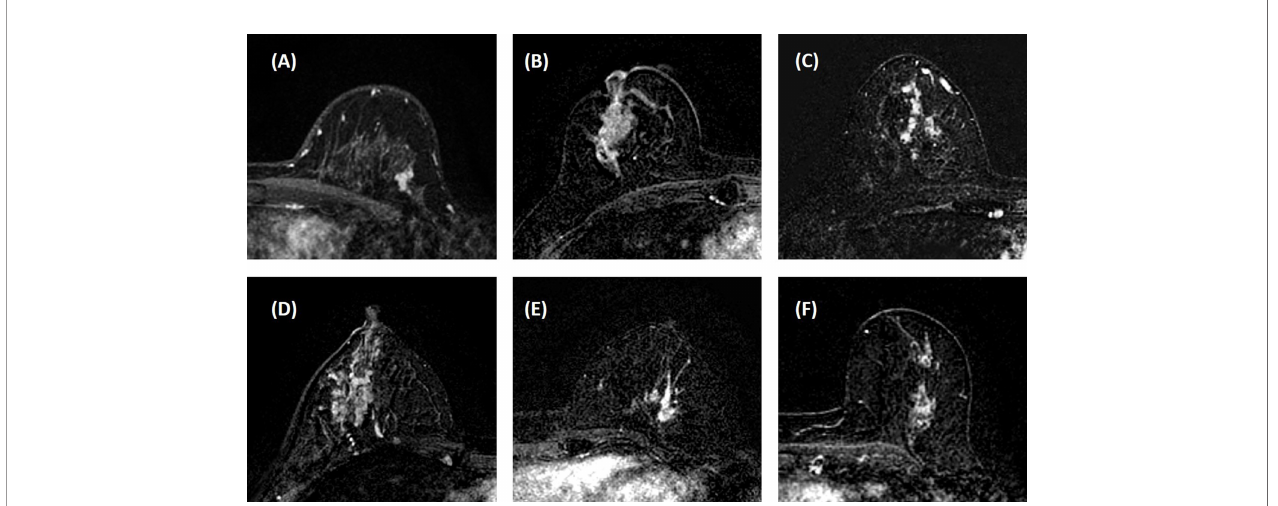
FIGURE 1 | Case examples of morphological distribution and internal enhancement pattern evaluated based on the 5th BI-RADS lexicon. (A) Forty-seven-year-old diagnosed with adenosis, showing focal distribution and homogeneous enhancement. (B) Forty-one-year-old diagnosed with ductal carcinoma in situ (DCIS), showing segmental distribution and heterogeneous enhancement. (C) Forty-three-year-old diagnosed with invasive ductal cancer (IDC), showing segmental distribution and clustered ring enhancement. (D) Thirty-six-year-old diagnosed with in fl ammation, showing regional distribution and heterogeneous enhancement. (E) Fifty-one-year-old diagnosed with IDC, showing regional distribution and clumped enhancement. (F) Fifty-two-year-old diagnosed with DCIS, showing multiple distributions and clumped enhancement. In these six cases, all three readers give consistent BI-RADS category results.